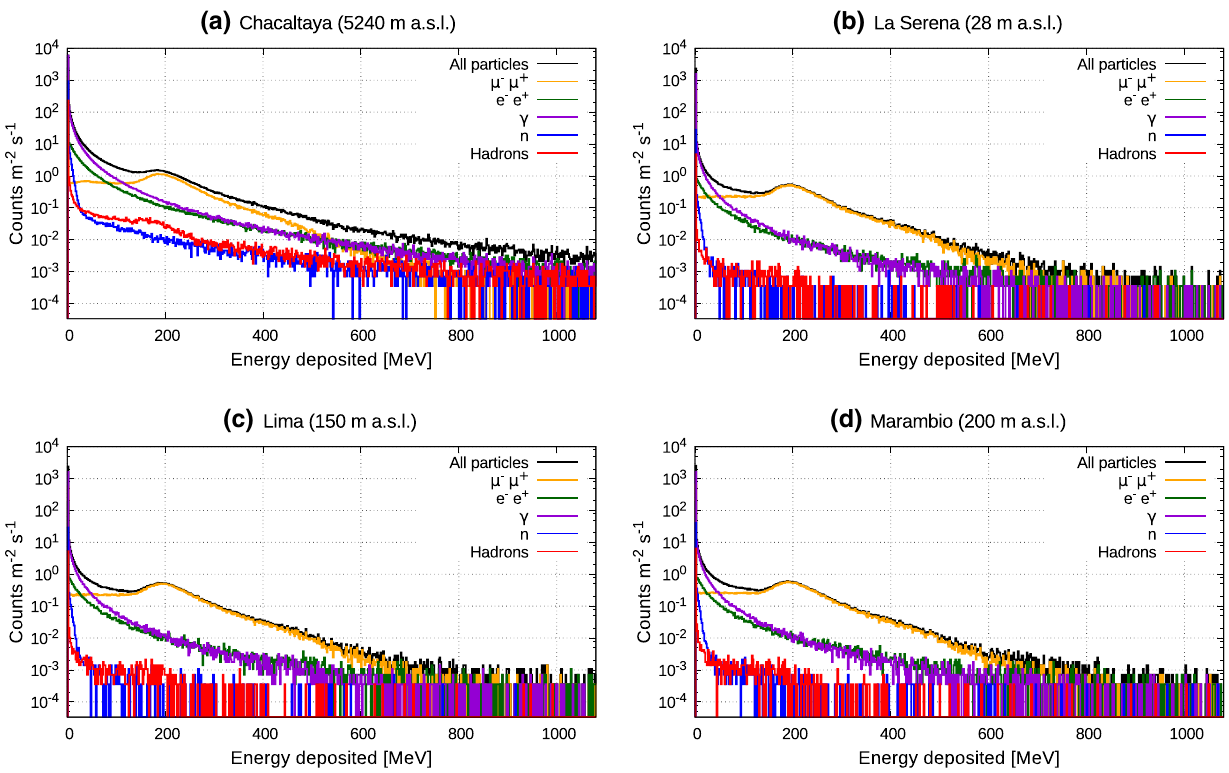
Fig. 6 Charge histograms for four LAGO sites of the total signal (black line) and single component contributions (colour lines): Chacaltaya ( a ), La Serena ( b ), Lima ( c ) and Marambio ( d ). The histograms have been normalized to areas of 1m 2 and exposure time of 1 s